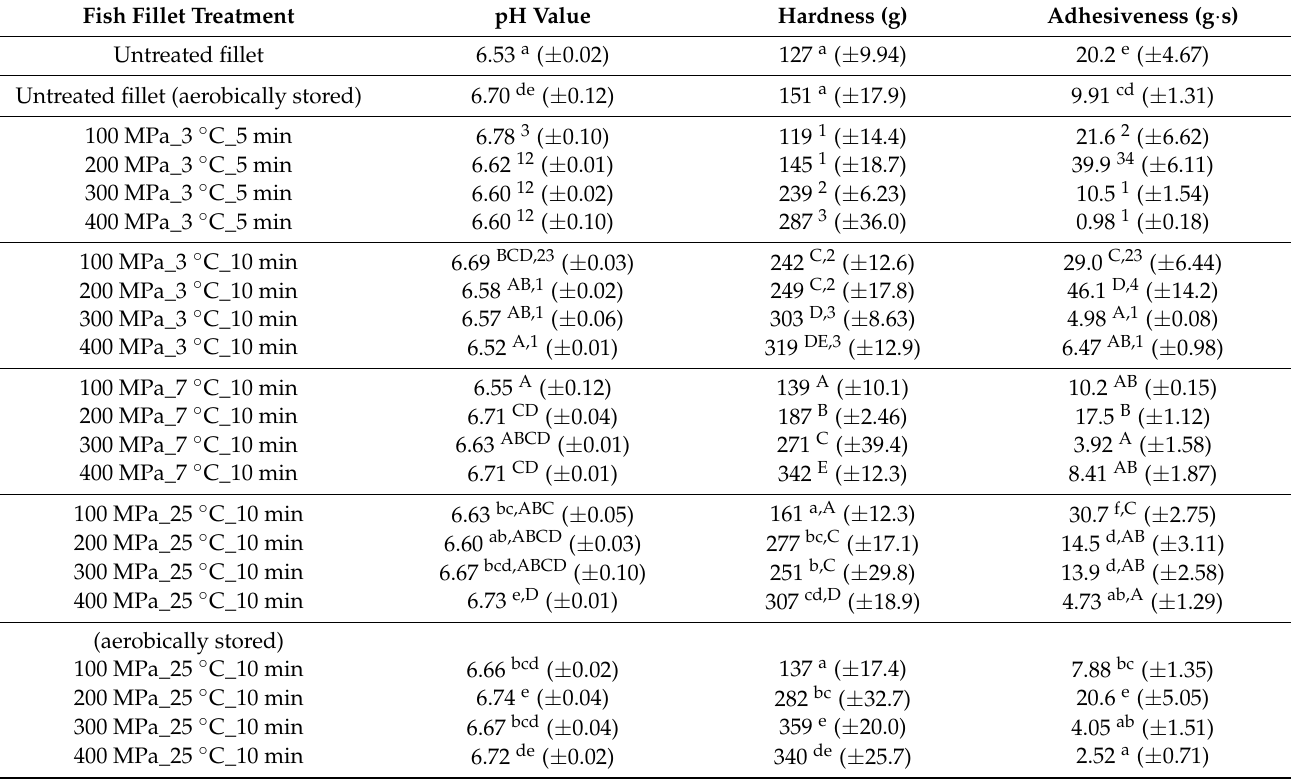
Table 3. Physicochemical characteristics of untreated and HP-treated sea bass fillets at the beginning of their shelf